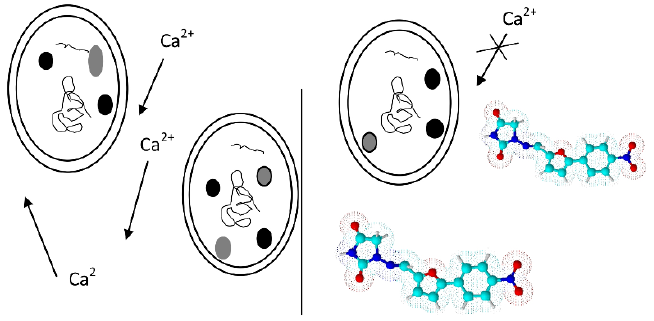
Scheme 5. The mechanism of action of dantrolene.